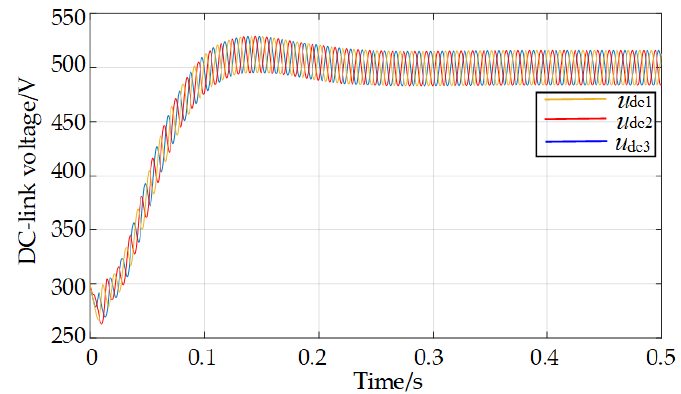
Figure 7. DC-link voltage responses.